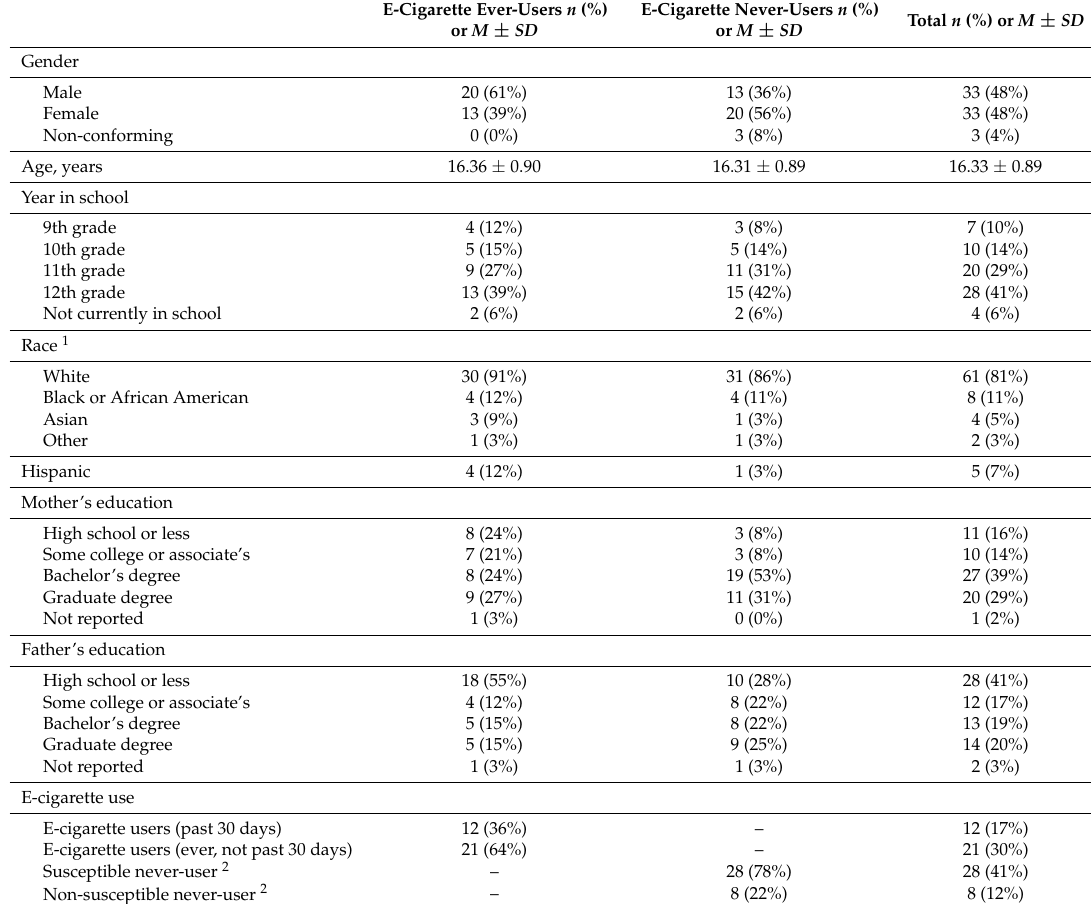
Table 1. Participant characteristics, N = 69